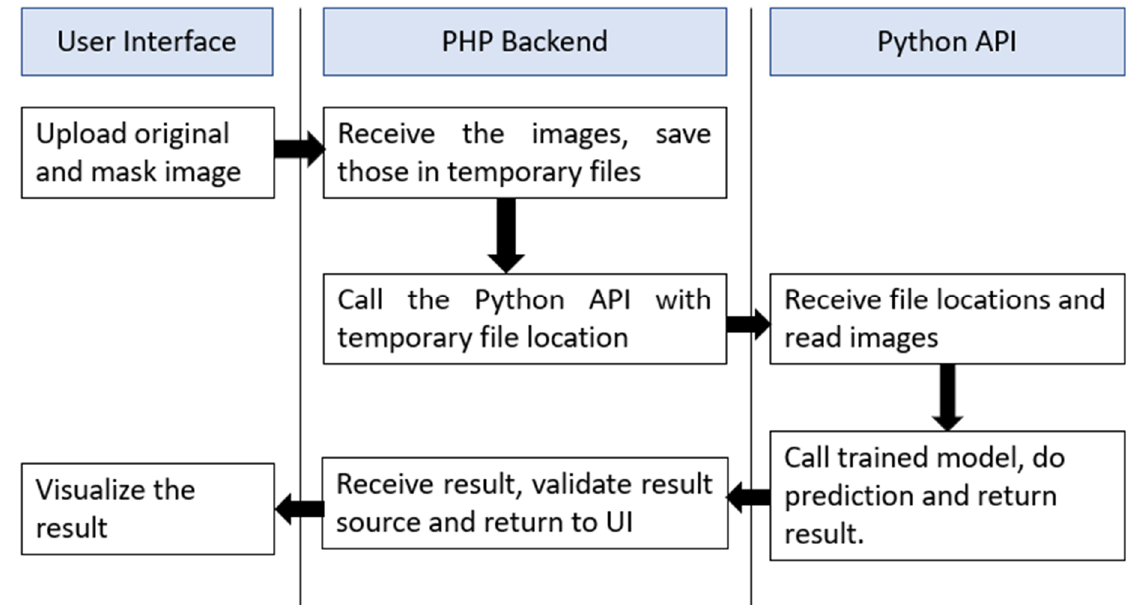
Figure 15. The software flowchart for the web interface of breast cancer detection.